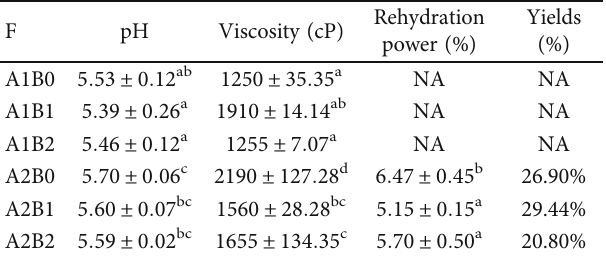
Table 3: Physical properties of cream soup